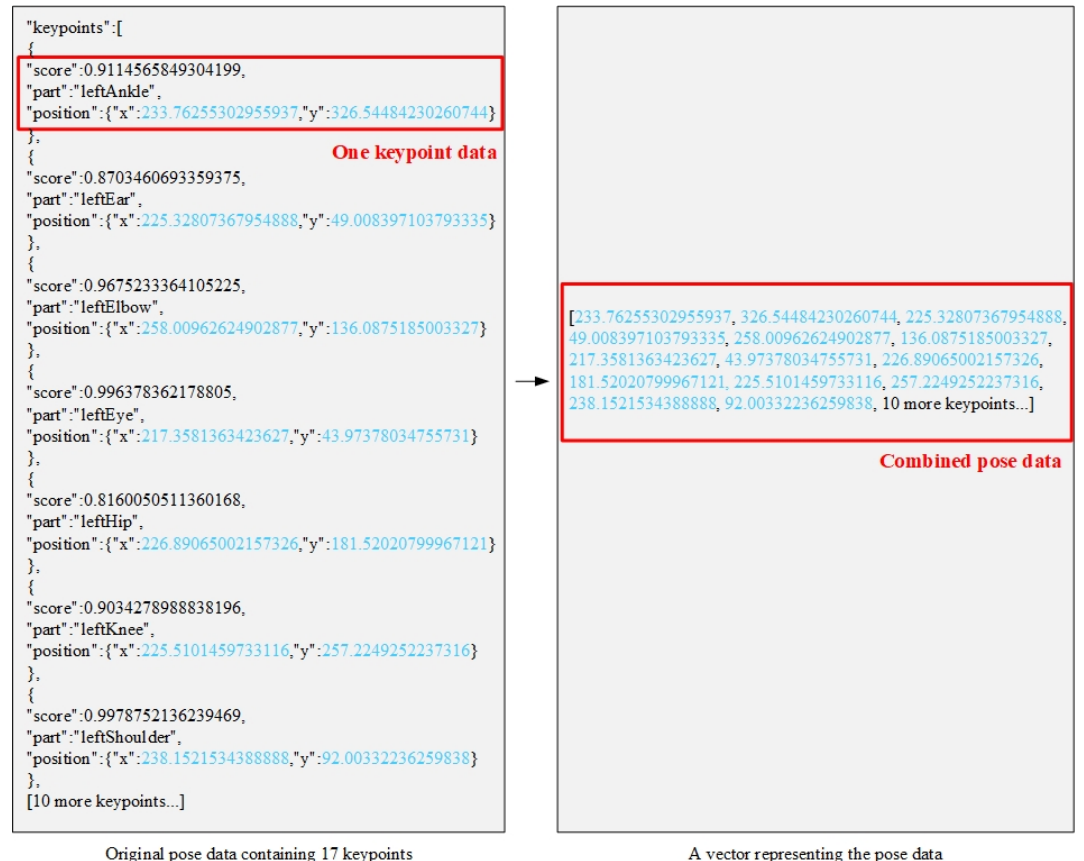
Figure 5. Compression of posture estimation data.